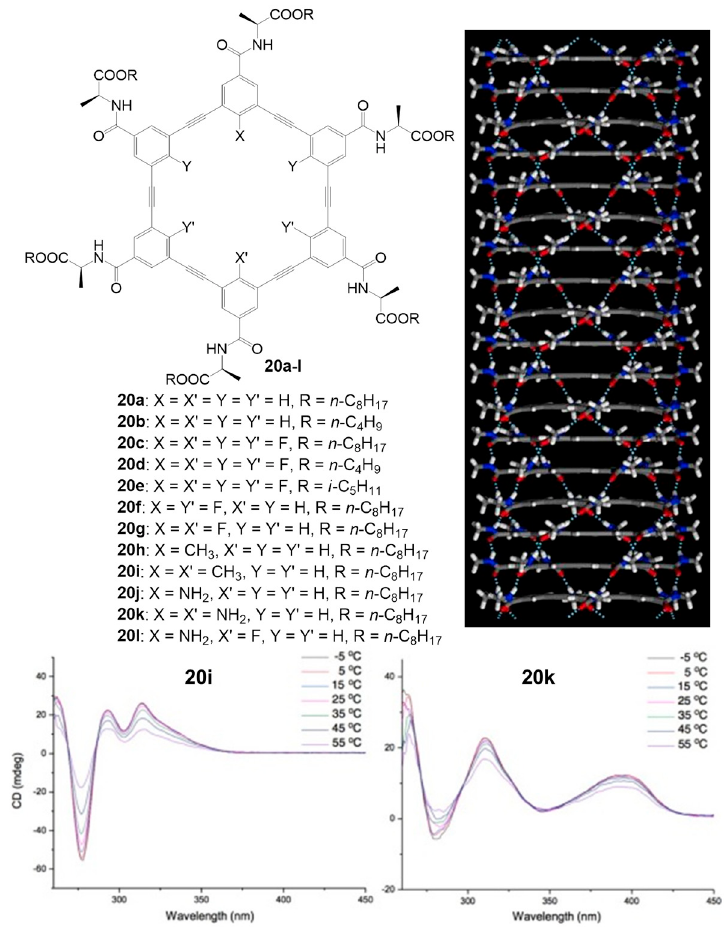
Figure 17. Structures of m -PE macrocycles 20a – l (top left), QMD simulation of a helical stack of the macrocycles (top right), and variable-temperature CD spectra of 20i and 20k measured in CCl 4 (10 µ M) (bottom). Partially reproduced with permission from Ref. [80] (Copyright Nature Publishing Group, 2012) and [81] (Copyright the American Chemical Society, 2016).